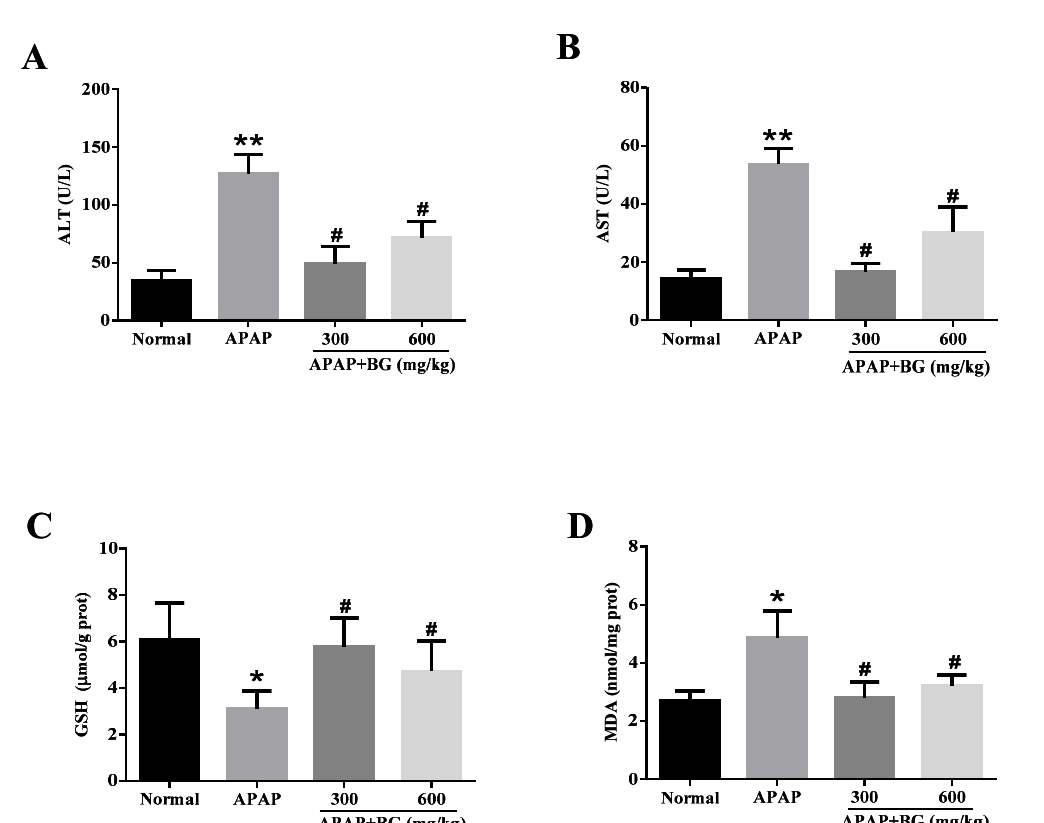
Figure 2. Effects of BG on levels of ALT ( A ) and AST ( B ) in serums, and GSH ( C ) and MDA ( D ) in liver tissues of mice. Values are expressed as the mean ± S.D., n = 8; ** p < 0.01, * p < 0.05 vs. normal group; # p < 0.05 vs. APAP group.